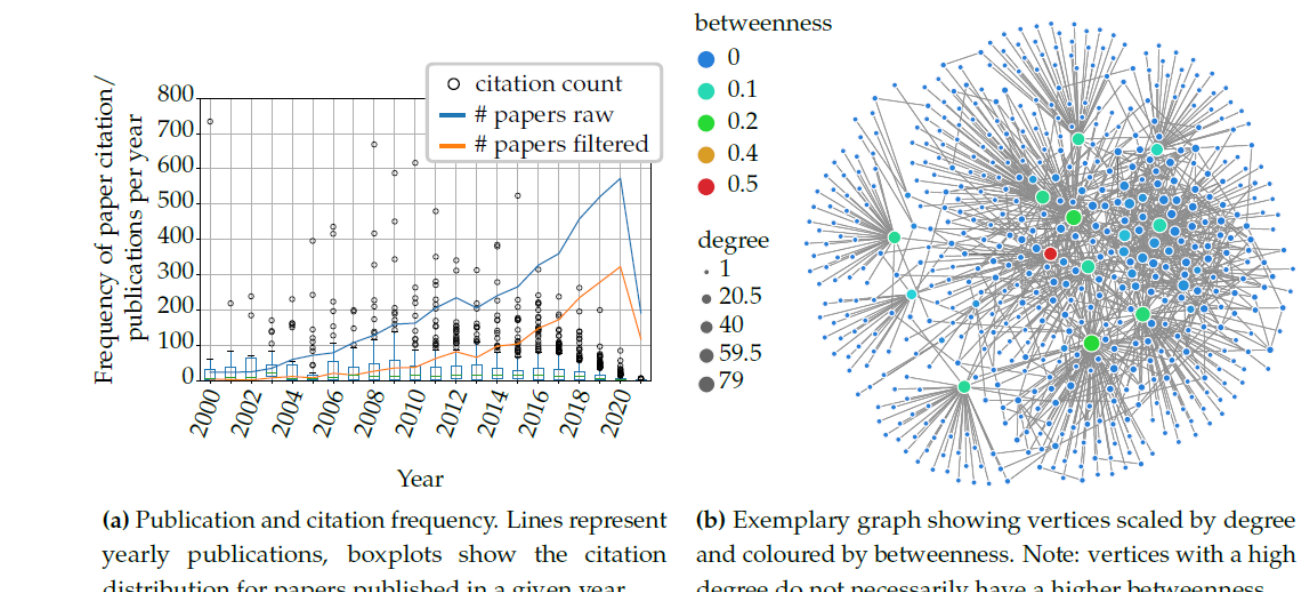
Figure 4. Methods used for filtering. ( a ) shows the approach of citation based filtering and ( b ) displays the concept of betweenness as an indicator for papers that potentially bridge gaps between